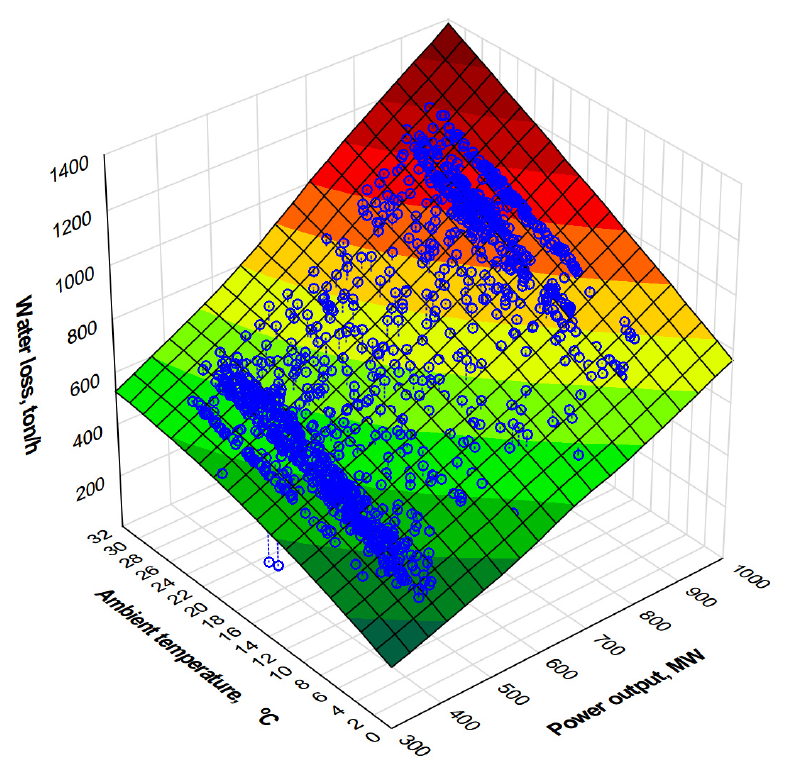
Figure 3. Dependence of water losses due to evaporation on the function of the unit power output and ambient temperature ( φ = 70 ± 5%).